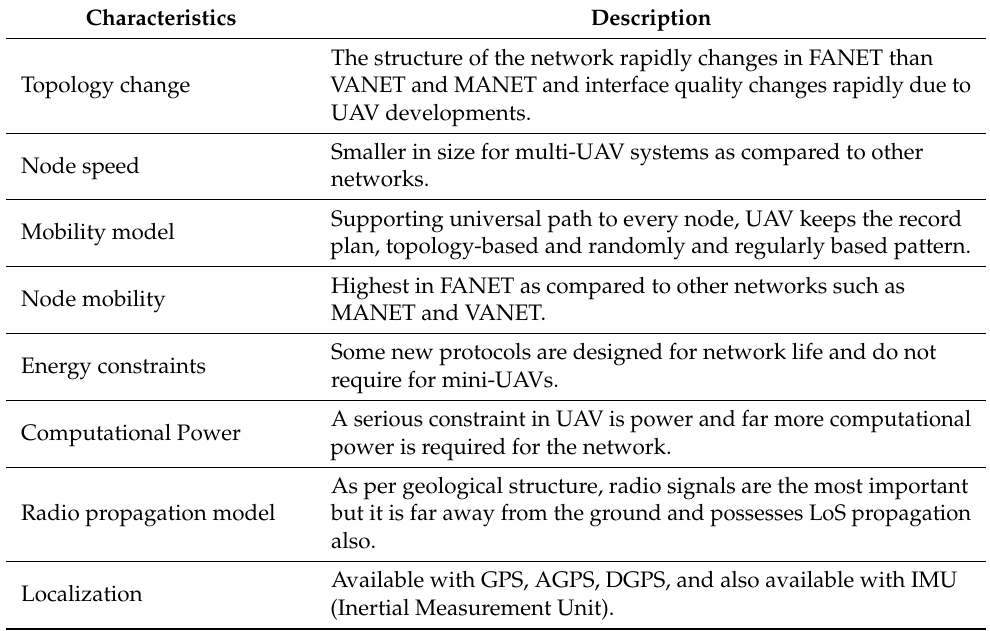
Table 1. Characteristics of flying ad-hoc